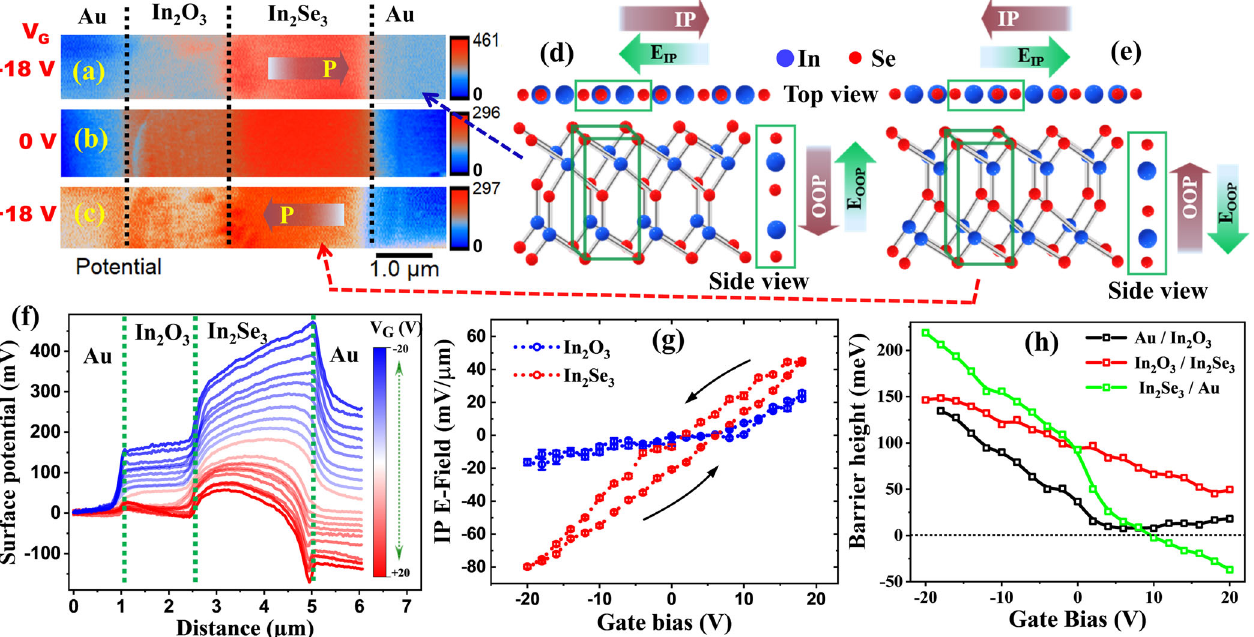
Fig. 3 KPFM characteristics to reveal intercoupled polarization and memory behavior. Surface potential mapping of the fabricated FET for ( a ) − V G , ( b ) 0 V G , and ( c ) + V G , showing the spatial potential distributions across different materials. The metal (M) and the two types semiconducting regions (In 2 O 3 and In 2 Se 3 ) and the polarization directions are marked accordingly. The schematic crystal structures exhibit the position of In and Se atoms for ( d ) negative and ( e ) positive gate-induced polarization. The intercoupled polarization (brown arrows) and the in-plane ( E IP ), and out-of-plane ( E OOP ) electric fi eld (green arrows) directions are marked for better visualization. f Surface potential line pro fi les across the FET channel for different gate-bias voltages (the regions of the respective materials are separated by green vertical dotted lines). The change in potential slope with applied gate-bias voltage indicates the dipole rotation. g In-plane electric fi eld at the middle of In 2 O 3 and In 2 Se 3 for a complete cycle of applied gate voltage (see Supplementary Fig. 4). A distinct potential slope, as well as remnant hysteresis nature (arrows indicate the gate sweep direction), is observed for the In 2 Se 3 region, while no hysteresis recorded for In 2 O 3 . The minor change